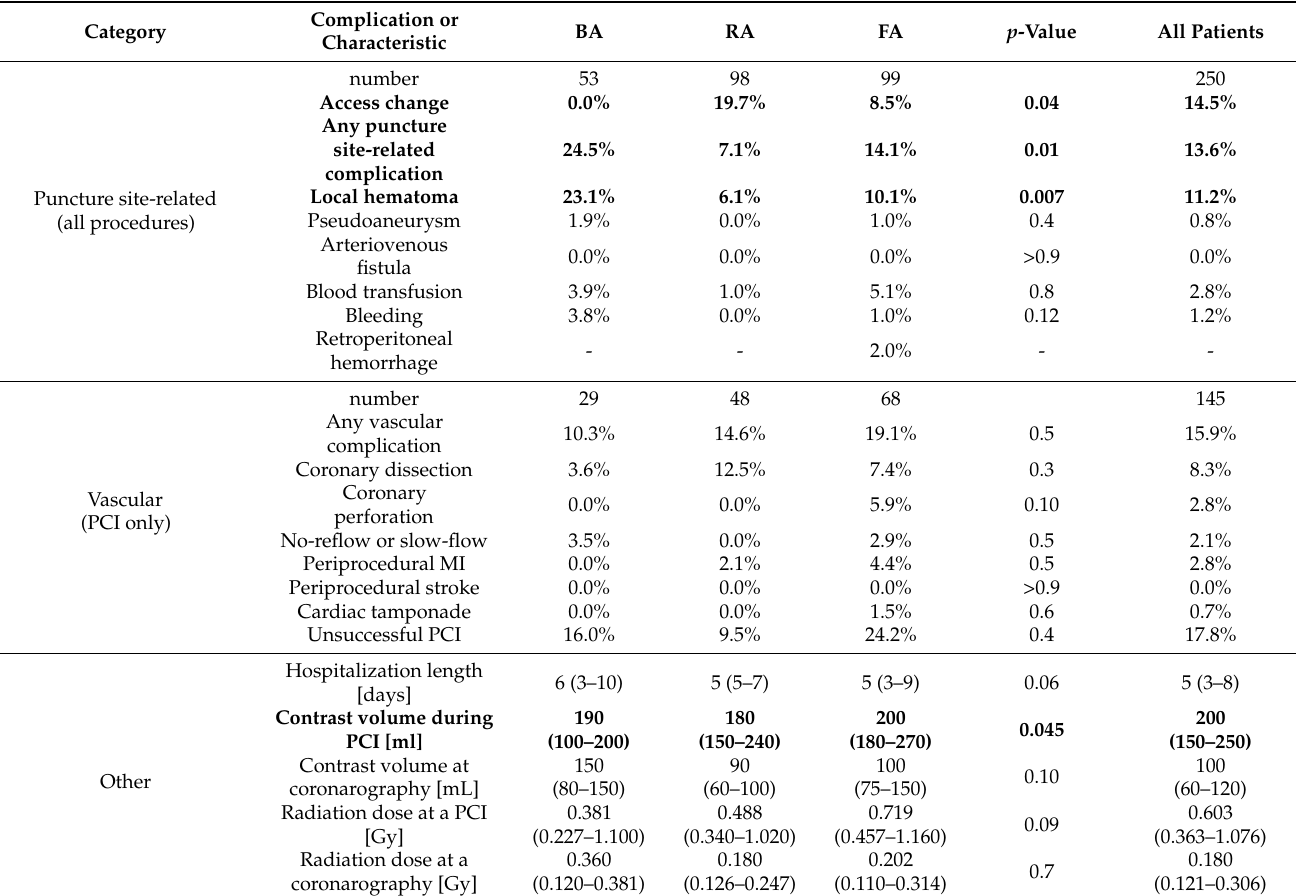
Table 3. Comparison of the frequency of complications according to vascular access